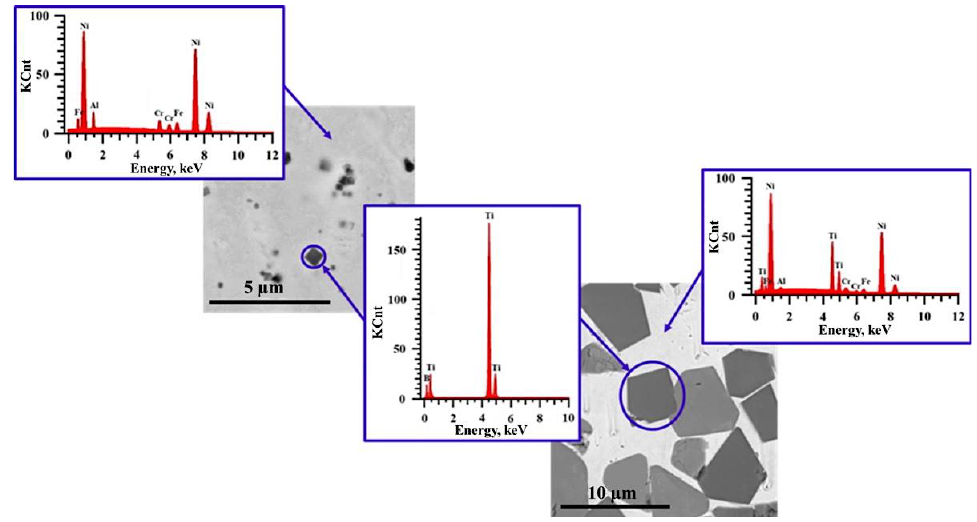
Figure 11. Qualitative elementary analysis of materials obtained by direct laser deposition from a